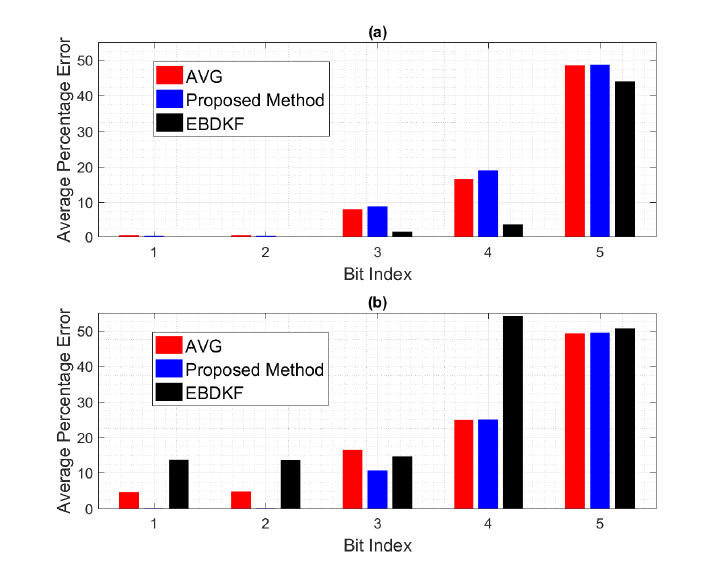
Figure 15. Bit level error performance comparison among the proposed statistical and the AVG information fusion method in a tree-based IoT platform when ( a ) BER = 0.005 and ( b ) BER =